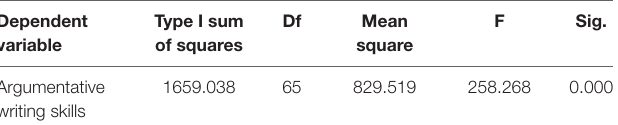
TABLE 2 | ANOVA of argumentative writing